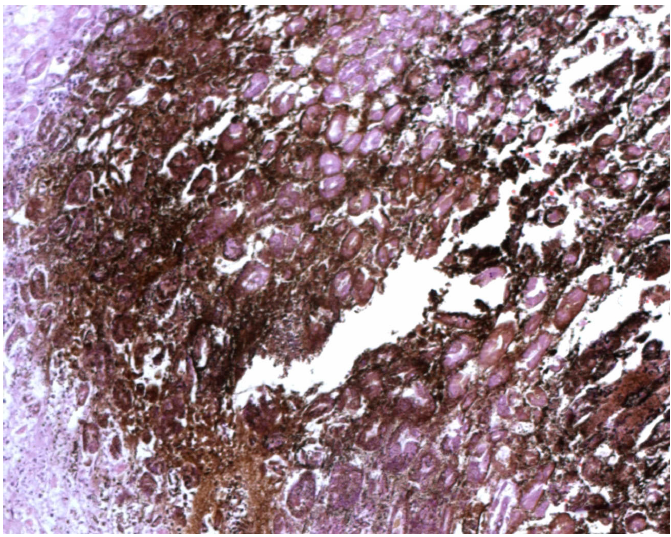
Figure 3. Microscopic analysis of WS with areas of glandular accumulation and lymphoplasmacellular infiltrate (H+E staining).